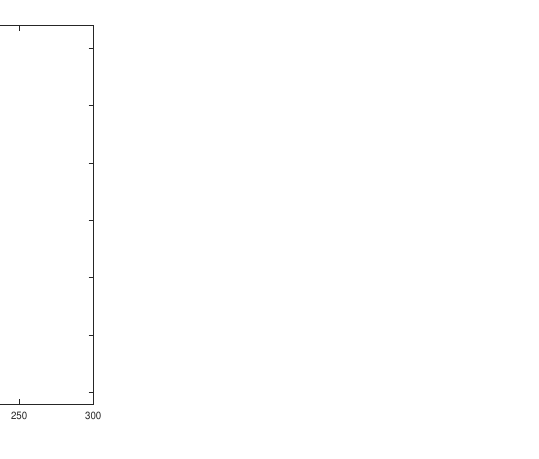
Figure 6. Irrigation function I ( t ) in days t . This function is considered bounded, continuous, differentiable, and periodic in order to represent a realistic case. Six watering applications were considered during the season.